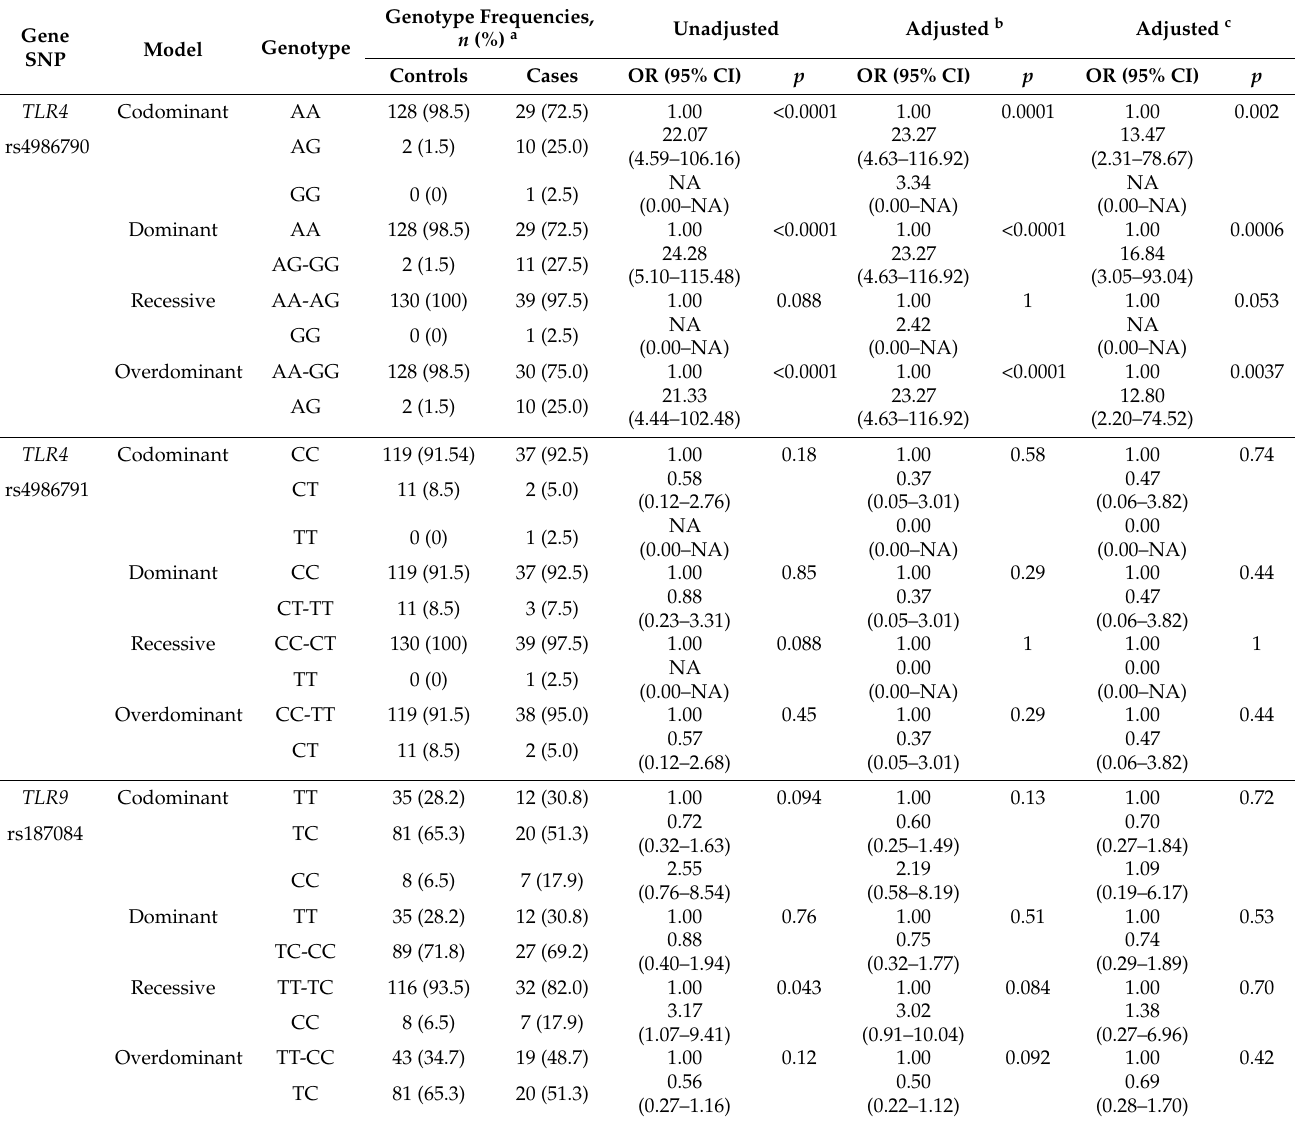
Table 3. The distribution of genotype frequencies of TLR SNPs in healthy women and those with HGSOC